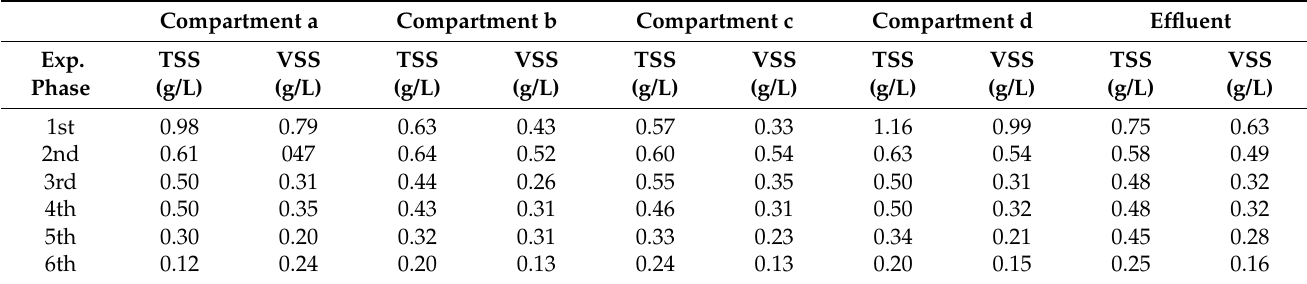
Figure 10 . Daily VSS concentration in reactor compartments.